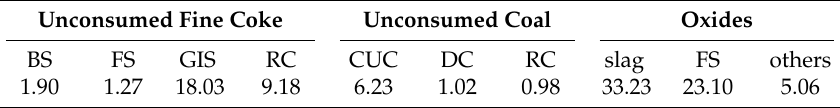
Table 2. Percentage of micro structure area ratio of different parts in recycling dust/%. Unconsumed Fine Coke Unconsumed